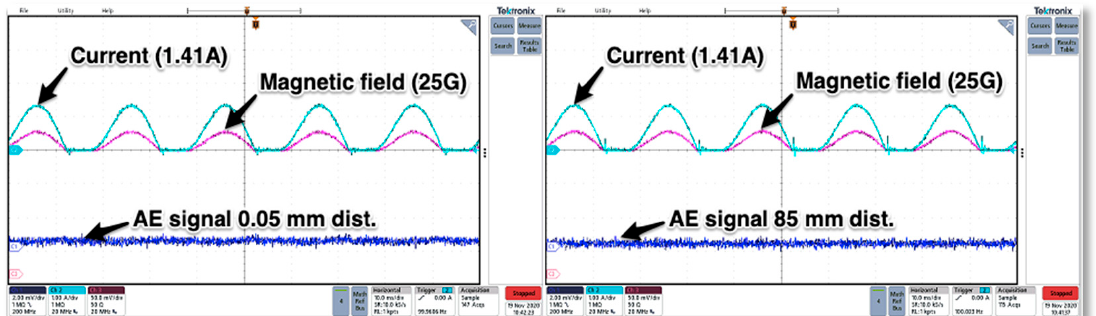
Figure 7. The test AE and magnetic field signals for rectified direct current flowing across the induction coil.